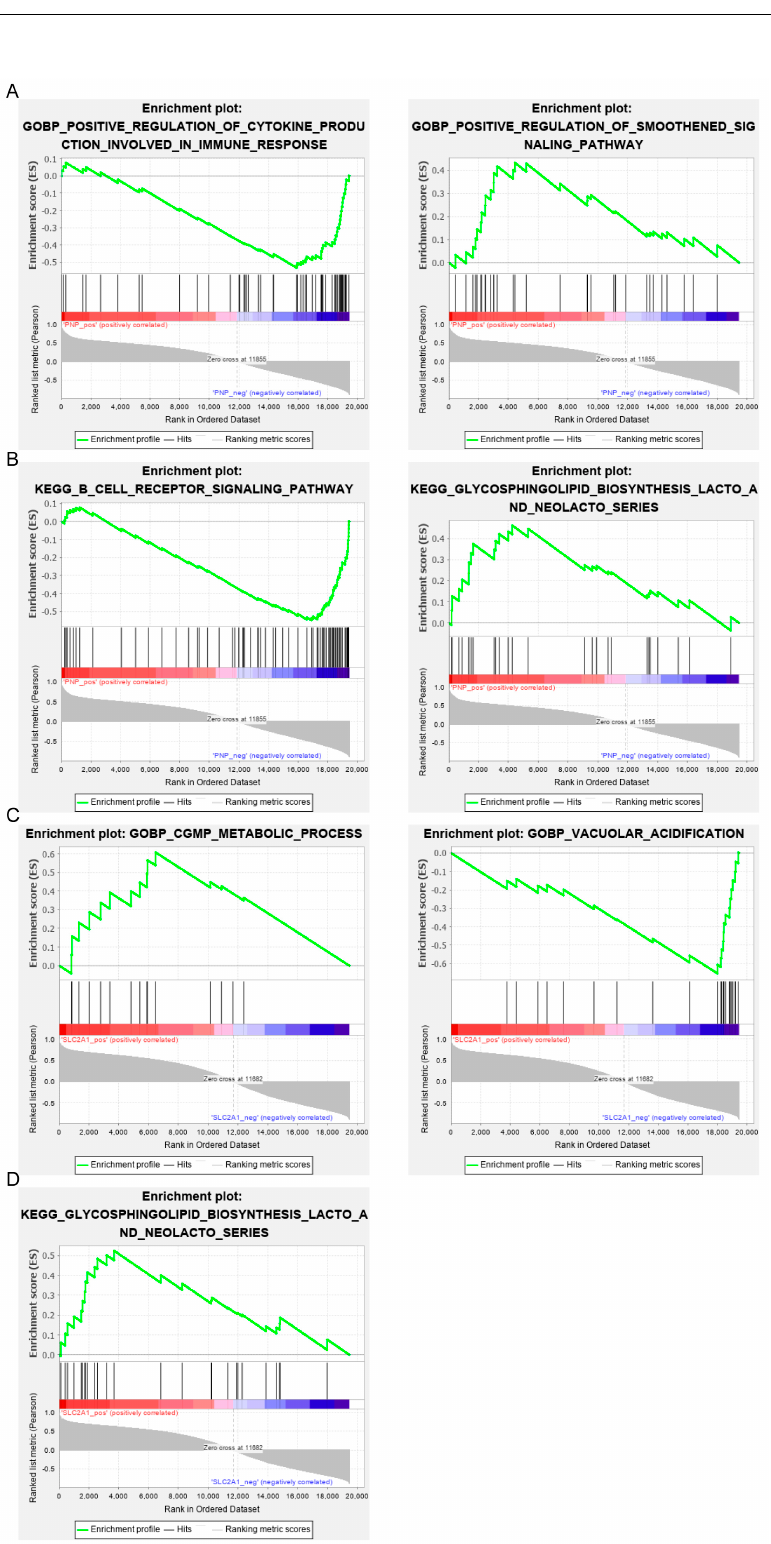
Figure 8. Single-gene GSEA of PNP and SLC2A1. ( A , B ) GO-BP and KEGG enrichment of PNP. ( C , D ) GO-BP and KEGG enrichment of SLC2A1. The threshold for enrichment significance was a NOM p value < 0.05. A positive enrichment score (ES) indicates that the tested gene set is enriched at the top of the pre-defined gene set, and a negative ES indicates that the tested gene set is enriched at the bottom of the pre-defined gene set. The ranked list matrix exhibits the correlation of the key gene with all other genes separately in the gene